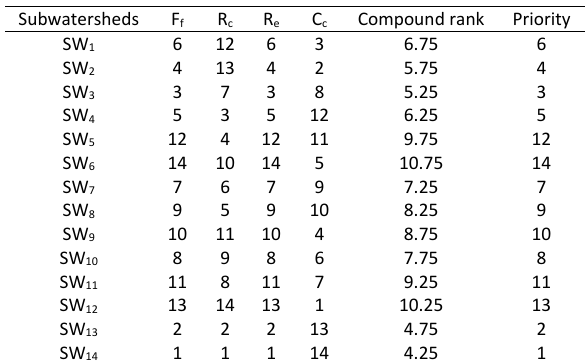
Table 6: Subwatershed ranks based on geomorphometric parameters with inverse effect to erosion Subwatersheds